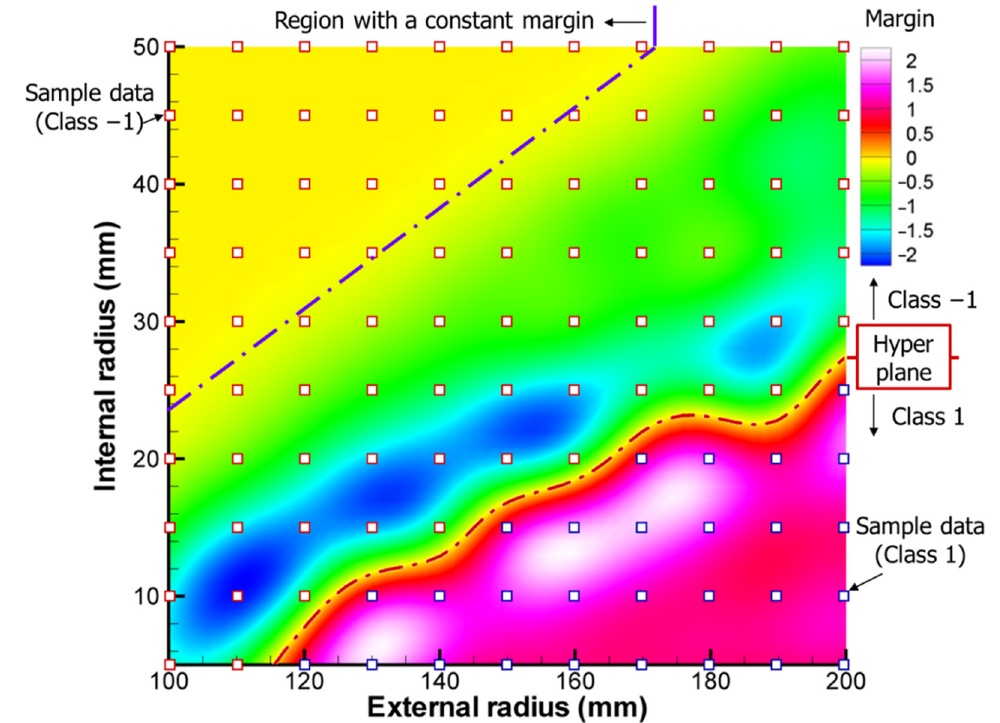
Figure 7. Example of margin contour. (w: 45 mm, f: 6 mm, e: 0.8).